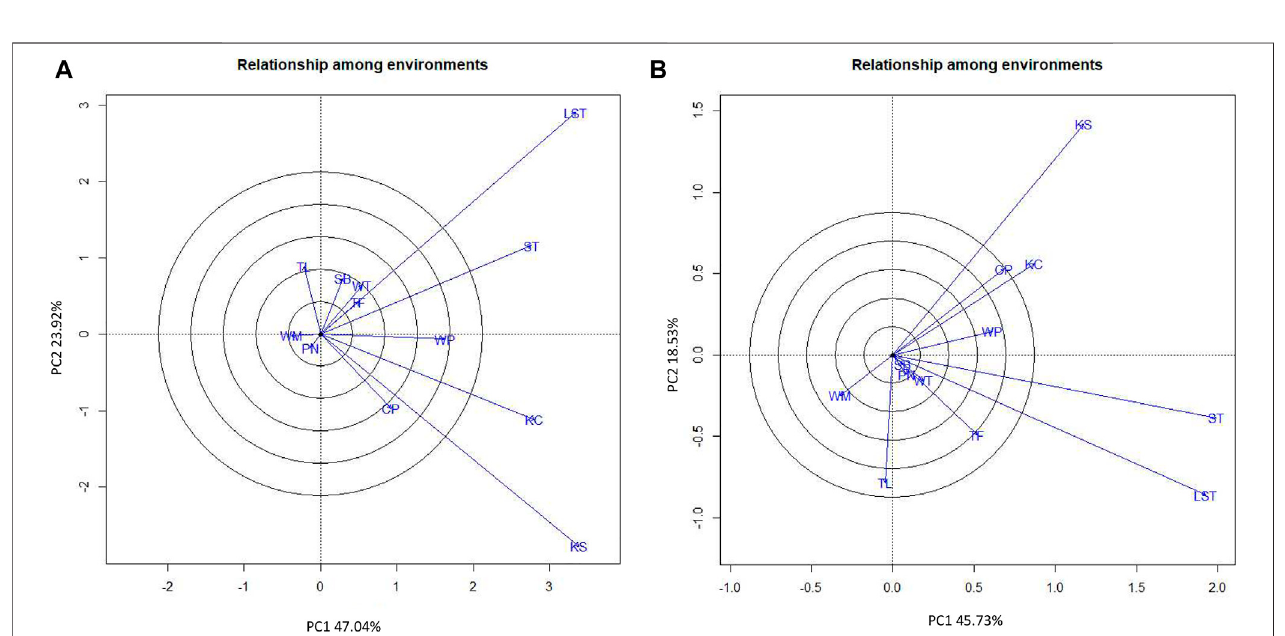
FIGURE 4 | GGE biplot showing discriminating ability and representativeness of test locations. (A) Pod yield. (B) Seed yield.